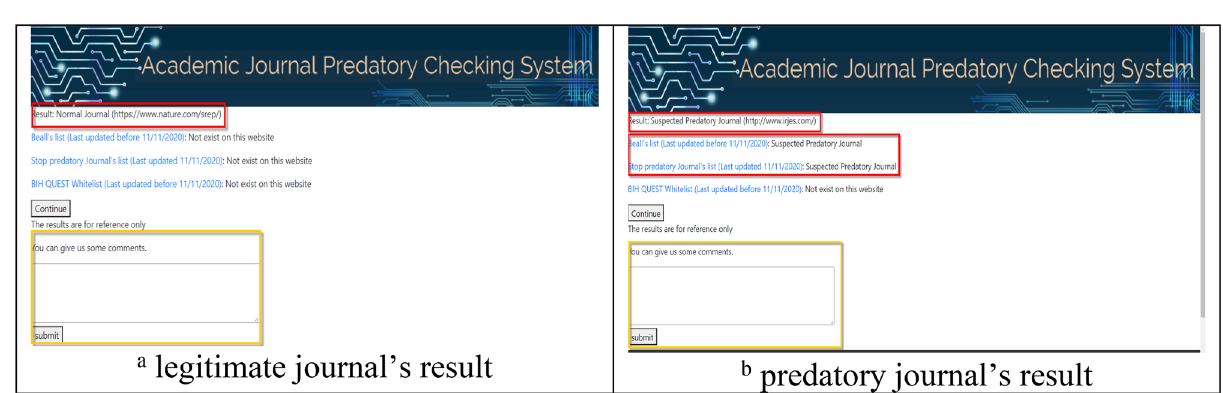
Figure 5. Legitimate and predatory journal query examples.